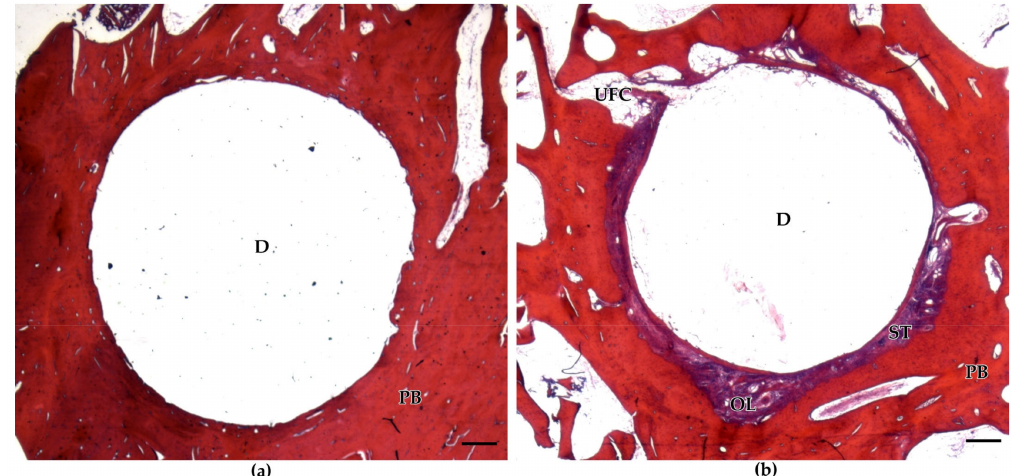
Figure 2. Representative decalcified and stained histological sections of BioM1 and BioM2: ( a ) de- fects (D) filled with BioM1 revealed a homogeneous bone-to-biomaterial interface with no signs of fibrous encapsulation; ( b ) defects filled with BioM2 are characterized by a pronounced enclosure with fibrous tissue (purple, ST). Further, osteolytic zones (OL) and univacular fat cells (UFC) are additionally present within the bone-to-biomaterial interface of implanted BioM2. Scale bar 500 µ m. (PB: peripheral bone).